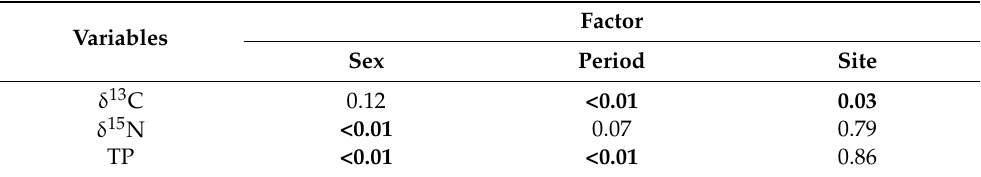
Figure 4. Mean ( ± SE) stable isotope values of carbon δ 13 C and nitrogen δ 15 N of male and female sticklebacks during three periods of spawning season. See Figure 1 for site description. Table 4. p -values resulted from three-way ANOVA (sex, period, site) for δ 13 C, δ 15 N and observed trophic position (TP) (significant values are marked in